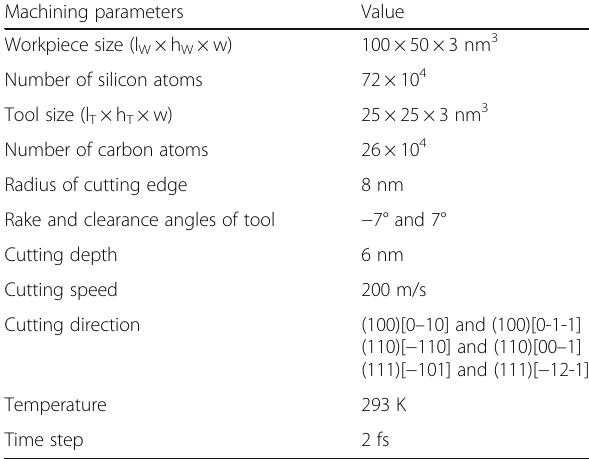
Table 1 Parameters used in the simulations Machining parameters